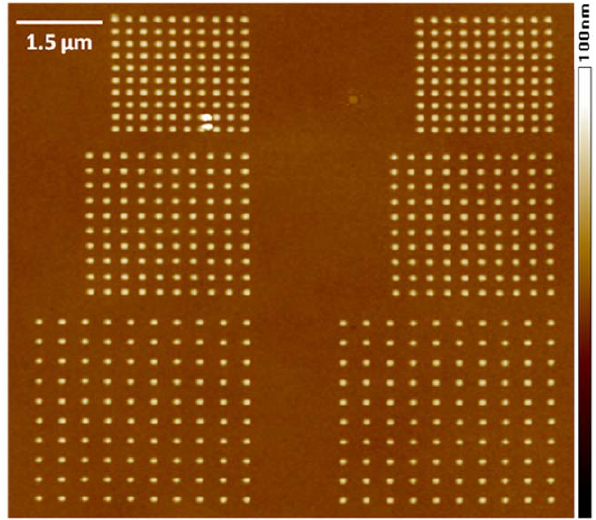
Figure 8. MFM image of the triple-stack ML-3D BPM. The MFM image corresponds directly to the nanopillars shown in the Figure 7.